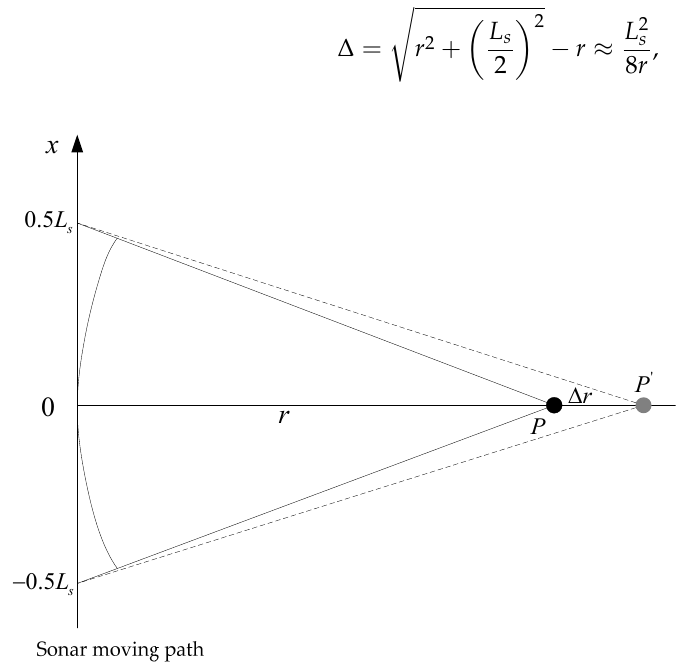
Figure 6. Block diagram of focus depth.